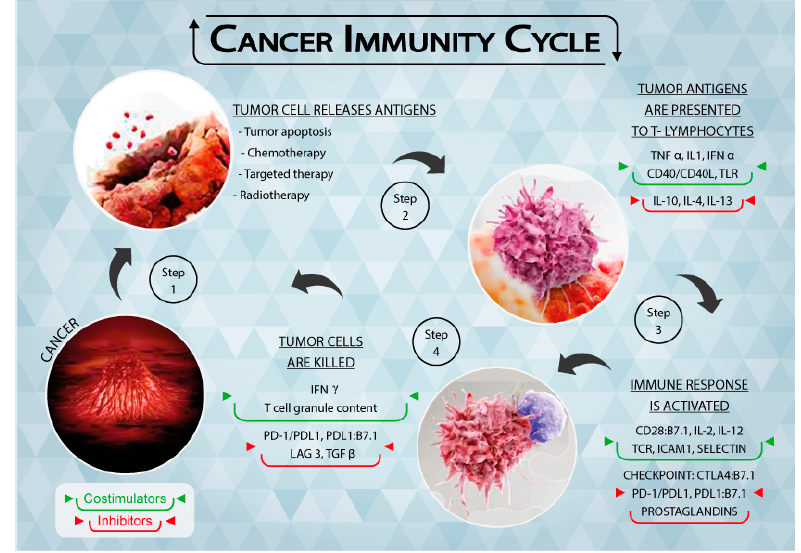
Figure 1. Schematic representation of the Tumor Immunity Cycle. As a consequence of apoptosis and anti-tumor treatments, cancer cells release tumor antigens (Step 1) that are presented to T lymphocytes through the major histocompatibility complex (MHC) (Step 2). The immune response is thus activated, together with immune checkpoints that regulate the extent of the response (Step 3). Cancer cells are recognized and killed by activated T lymphocytes (Step 4), causing them to release further tumor antigens. Figure 1 is complete ownership of authors.